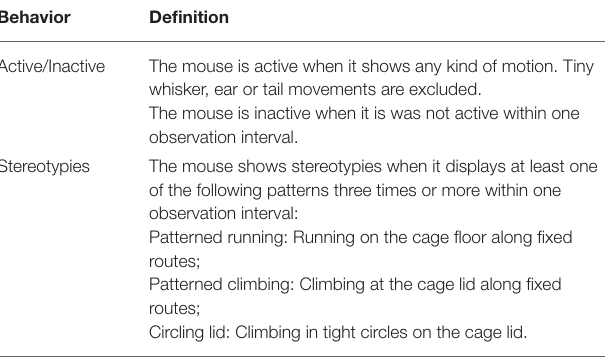
TABLE 1 | Definitions of behaviors, based on previous publications (3,